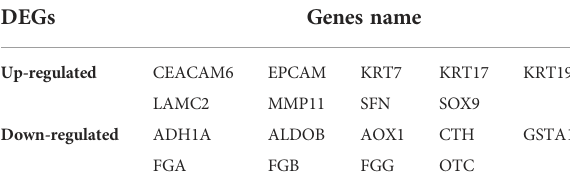
TABLE 3 Selection of 9 up-regulated and 9 down-regulated DEGs.